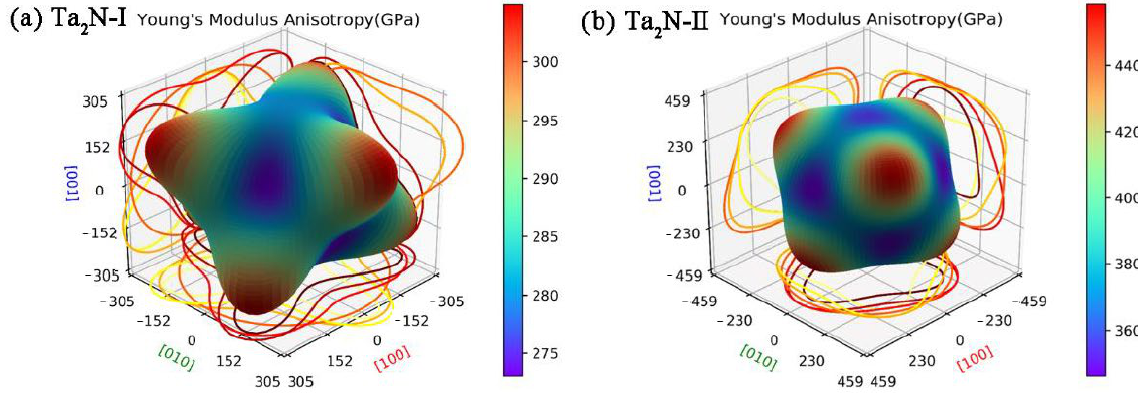
Figure 4. The three-dimensional anisotropy diagram of Young’s modulus E of ( a ) Ta 2 N-I and ( b ) Ta 2